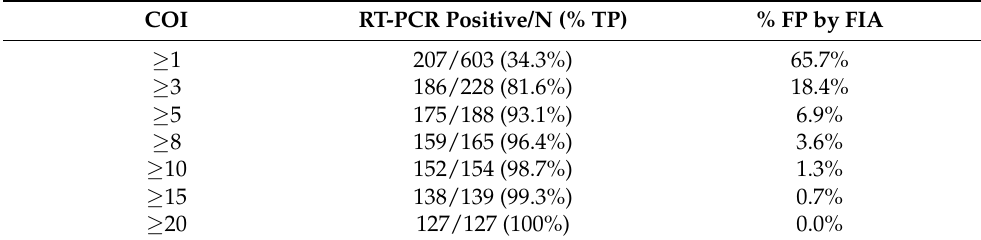
Table 1. Percentage of confirmed FIA-positive results by SARS-CoV-2 RT-PCR according to the COI values ( n = 603, as in yellow box of Figure 1).